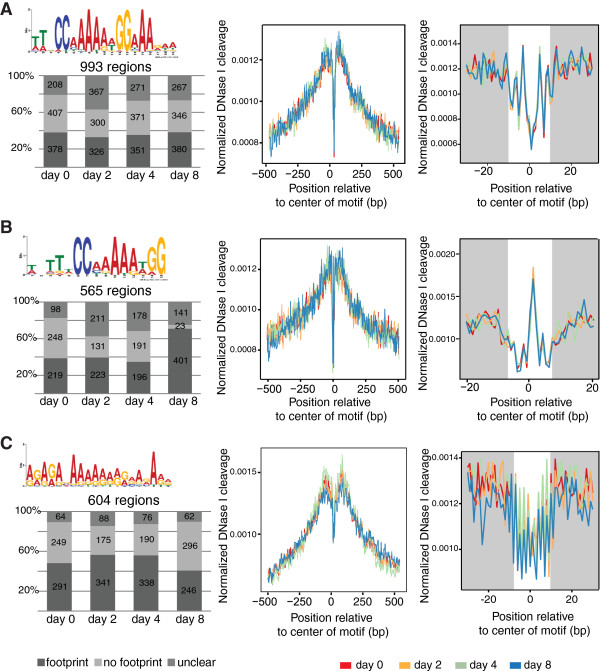
DNase I footprints created by TF binding at different time points of flower development. CArG box motifs were identified by MEME-ChIP in the AP1 and SEP3 peak regions (full list of motifs identified by MEME-ChIP in Additional file 3: Figure S4C). Footprints for selected motifs are shown in the right part of the Figure. (A) CArG-box 1 produces footprints at similar frequency at every time point. (B) CArG-box 2, identified only in the SEP3 ChIP-seq data, shows an increased footprint frequency at day 8. (C) An example of GA-rich motif, which produces more frequently footprints at early time points of flower development.